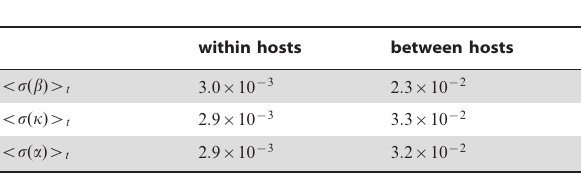
Table 1. Average plasmid parameter